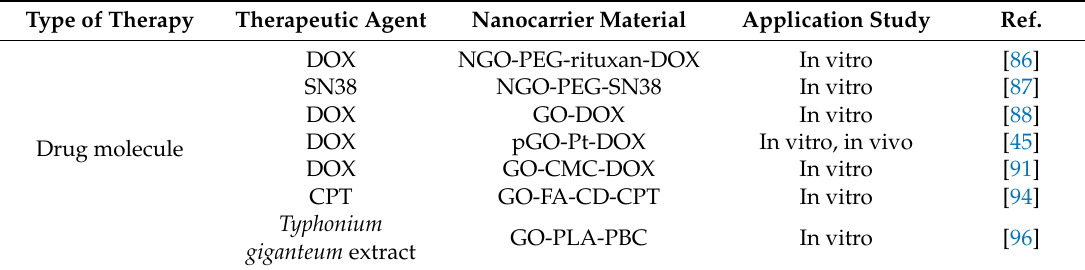
Table 3. Comprehensive list of GO-based nanocarriers for delivery of biochemical molecules. Type of